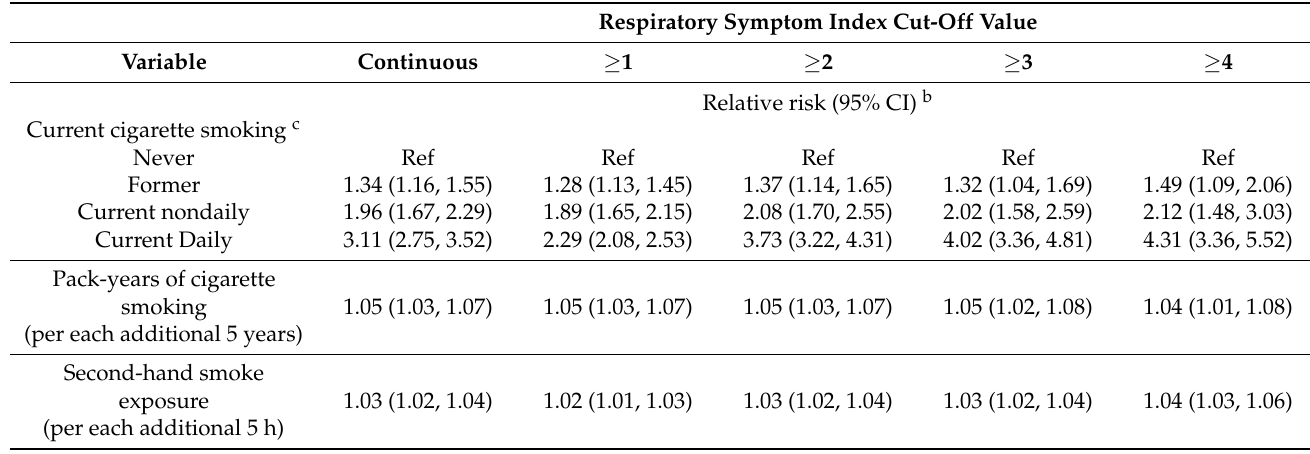
Table 5. Weighted relationship between different thresholds for functionally important respiratory symptoms and associa- tion with cigarette exposures, Wave 2 (2014–2015) of the PATH Study.